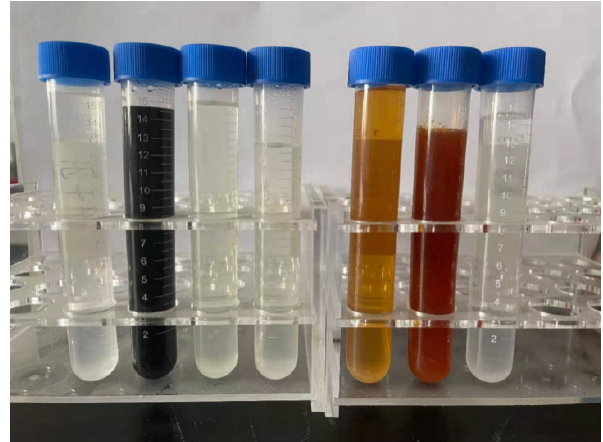
Figure 9. Solidification effect of different modifiers on borax.